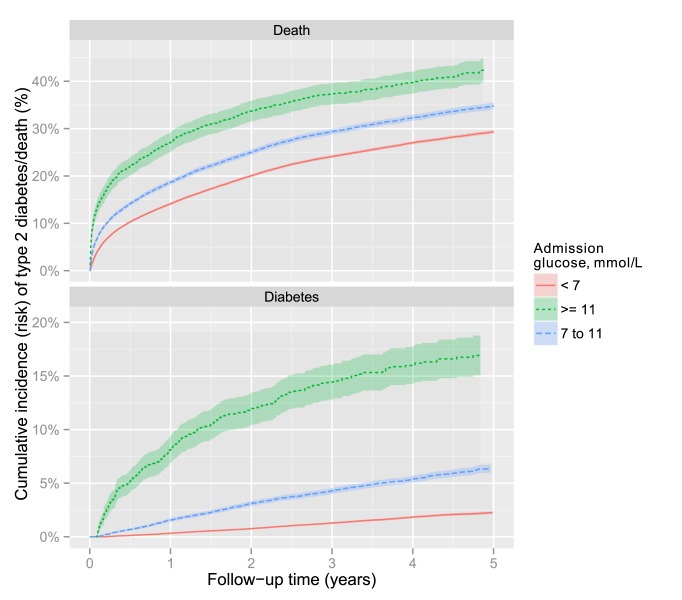
Cumulative incidence of mortality and type 2 diabetes by admission glucose.Non-parametric estimates of cumulative incidence of mortality and incident type 2 diabetes according to admission glucose. The ribbon represents the 95% CIs.